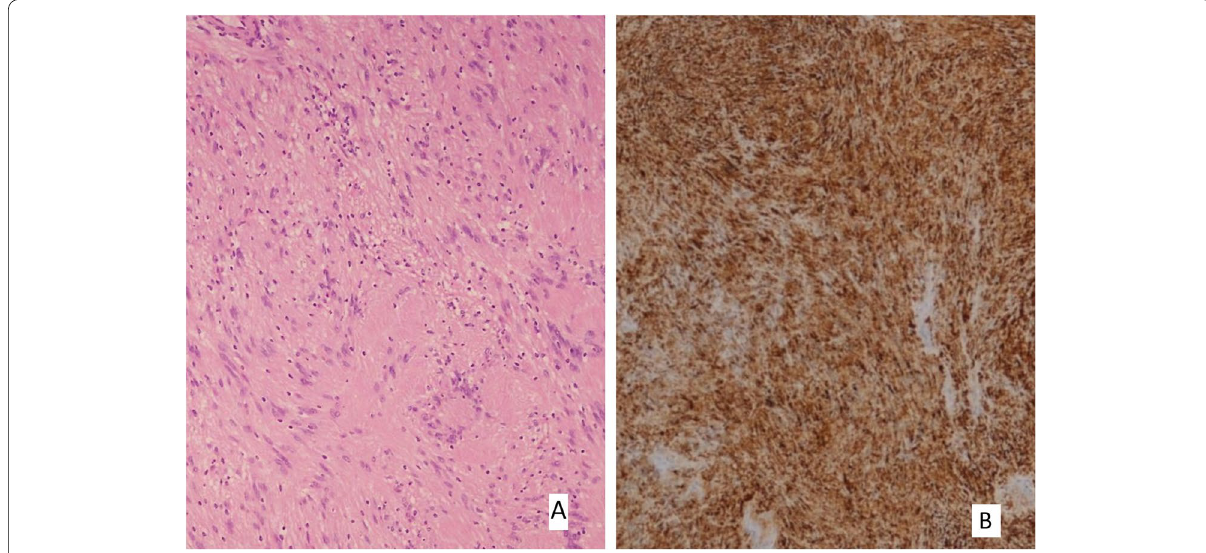
Fig. 2 Photomicrographs of schwannoma. A The tumor consists of a tight arrangement of cells with curled nuclei and fibrillar cytoplasm (HE 100). B Positivity of diffuse S-100 in tumor cells (IHC ×